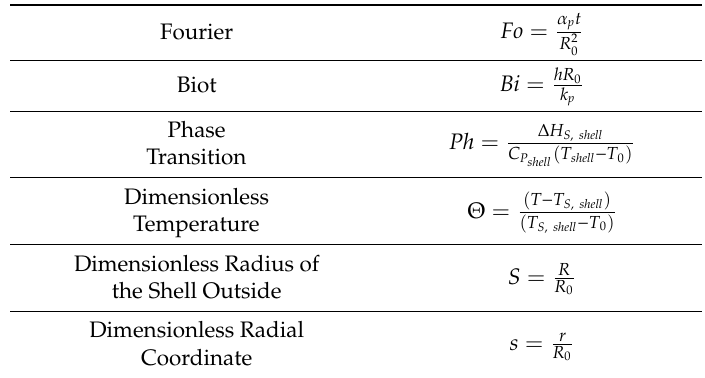
Table 3. Dimensionless numbers for heat transfer [25].